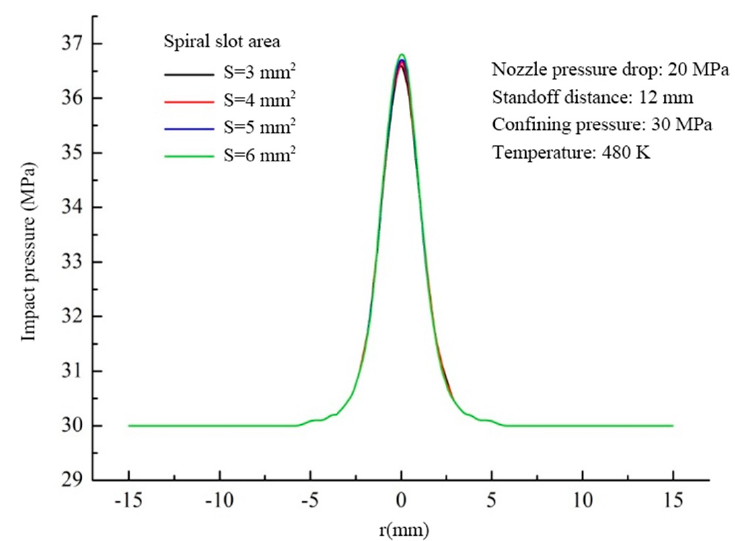
Figure 13. Influence of grooving area on impact pressure.